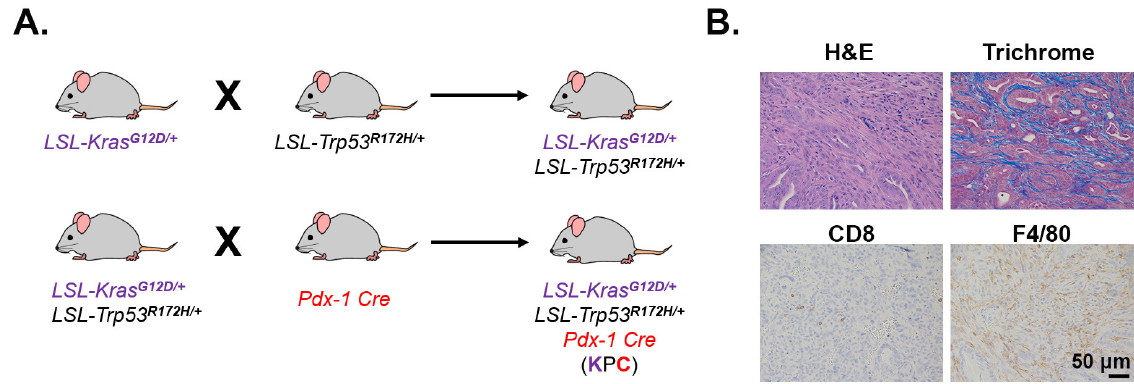
Figure 4. Desmoplasia, CD8 + T cells, and macrophage infiltration in GEMM KPC tumors. ( A ). Breeding scheme to generate the genetically engineered KPC mouse model. LSL, LoxP-Stop-LoxP; Pdx-1, pancreatic and duodenal homeobox-1. ( B ). A PDAC tumor in a 6-month old KPC mouse was H&E or trichrome stained (10 × ) or stained by immunohistochemistry for CD8 + T cells and the macrophage marker F4/80 (20 × ). Antibodies used: CD8 (Cell Signaling, #98941) and F4/80 (Cell Signaling, #70076).